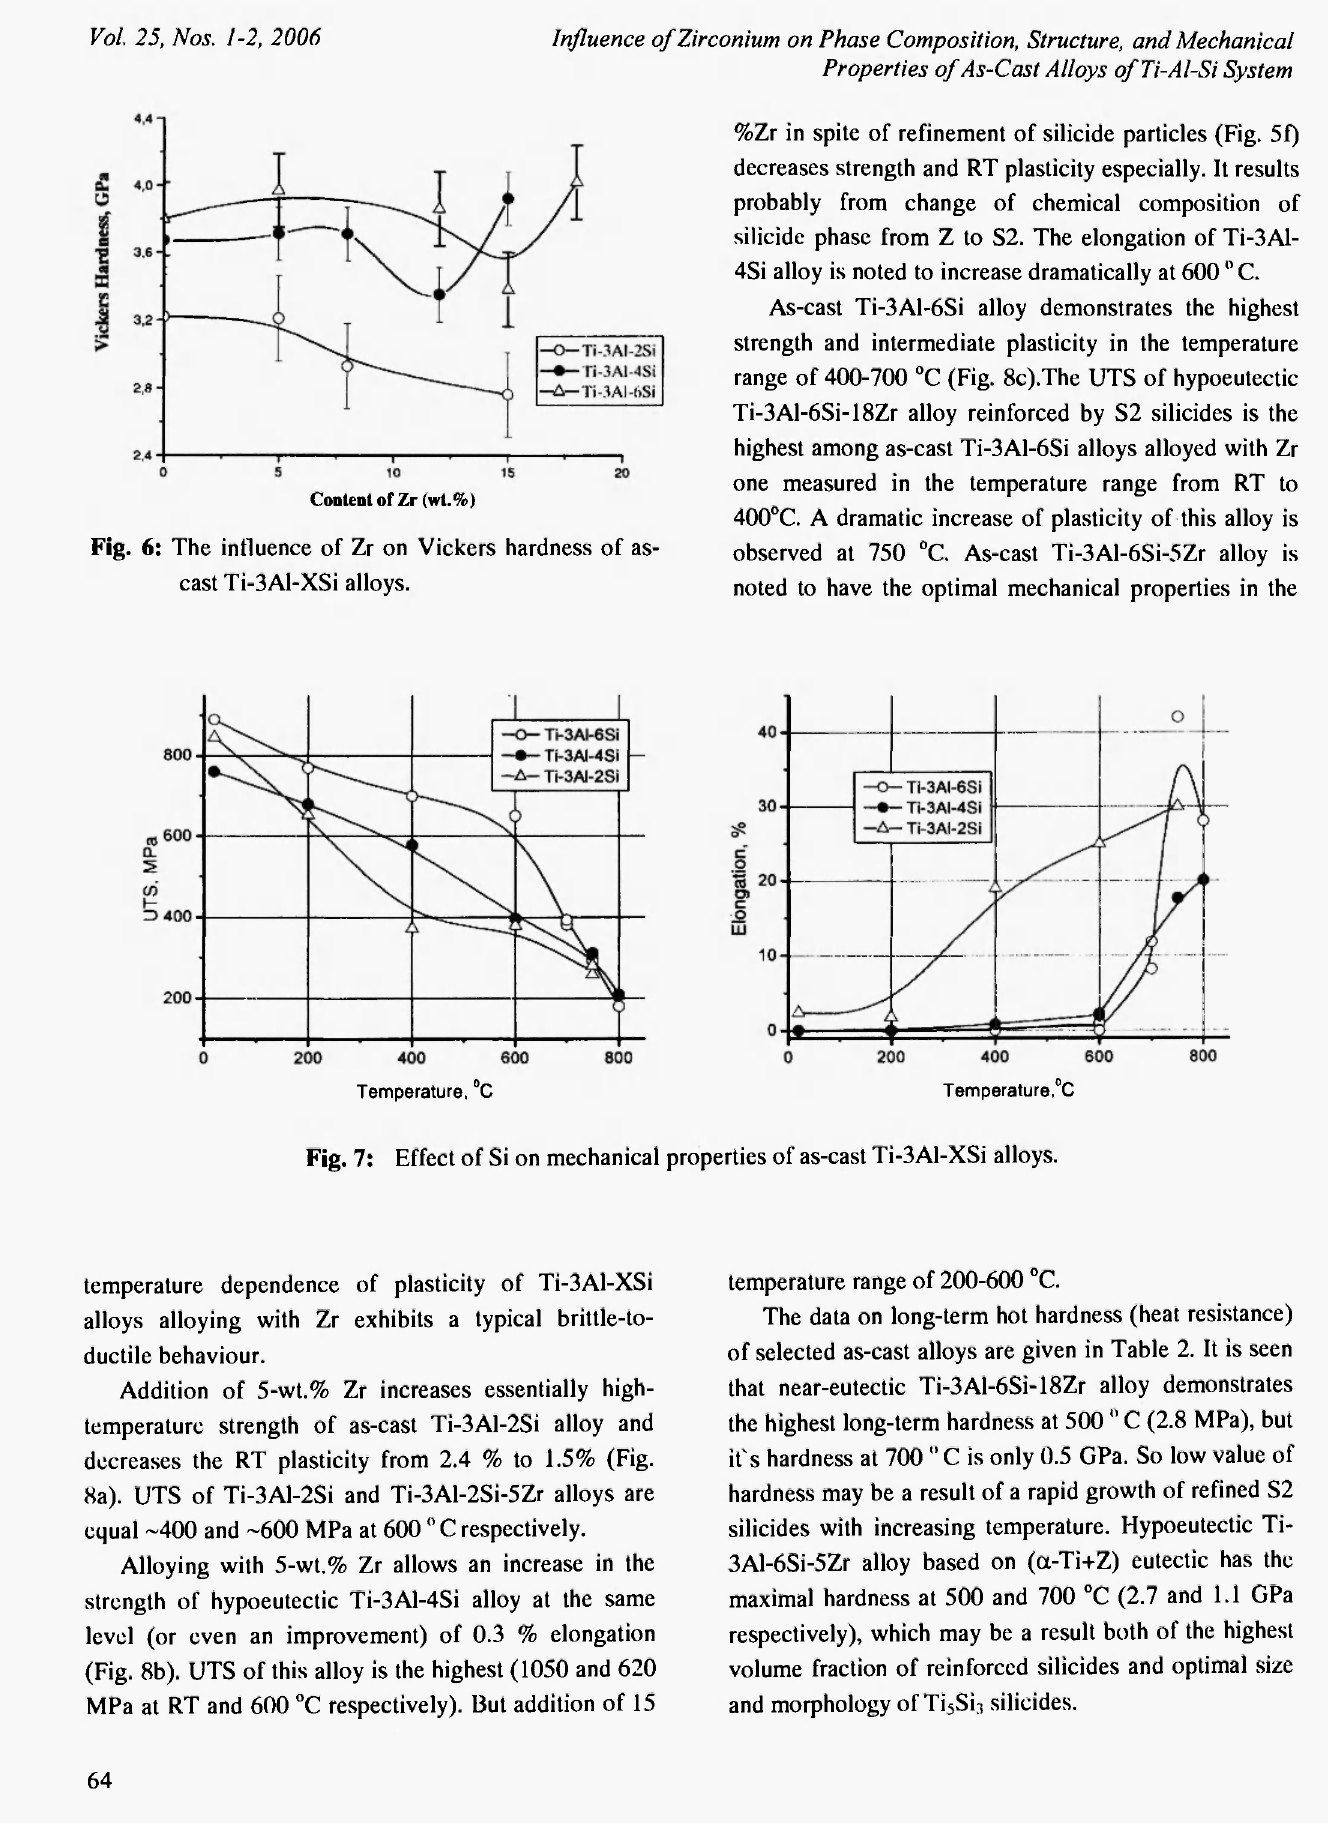
Fig. 7: Effect of Si on mechanical properties of as-cast Ti-3Al-XSi